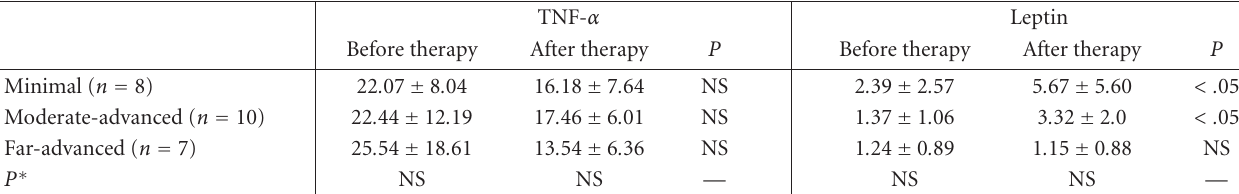
Table 3: TNF- α and leptin levels according to chest X-ray scores. Data presented as mean ± SD.